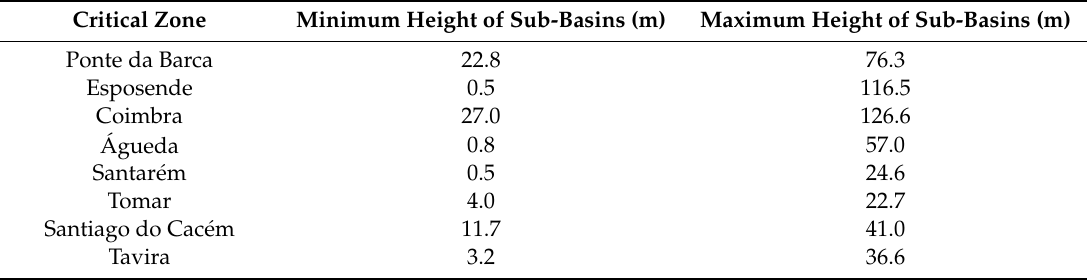
Table 1. Minimum and maximum sub-basins heights distributed by Critical